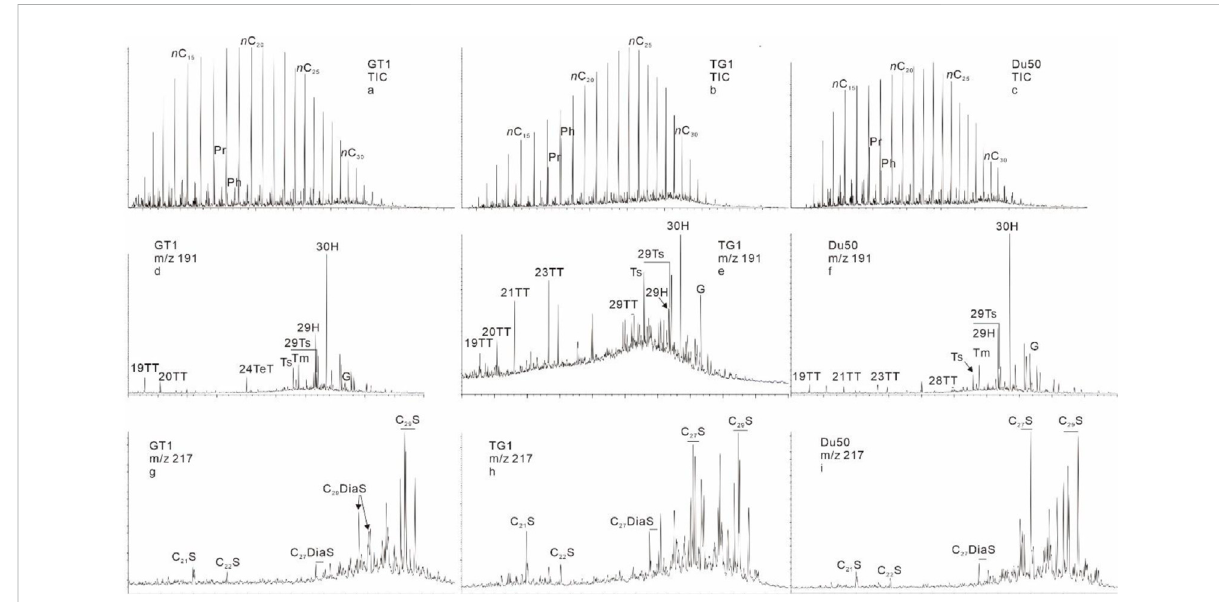
FIGURE 3 (A – C) TIC ofsaturated hydrocarbonsshowing distributions of n- alkanes and acyclic isoprenoids; (D – F)